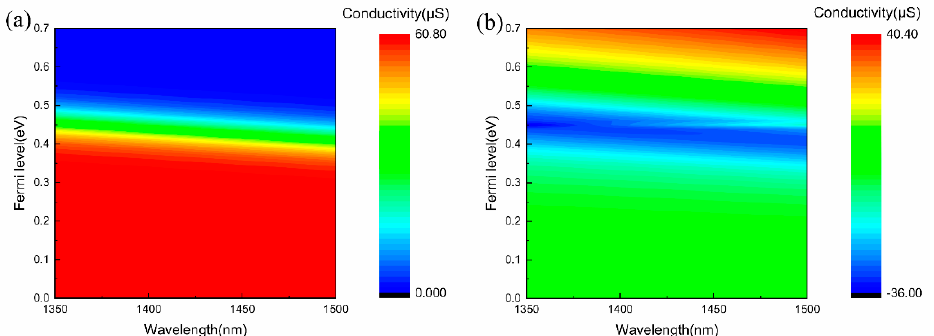
Figure 2. The relationship of graphene’s conductivity with different incident wavelengths and Fermi levels. ( a ) Real part of the conductivity. ( b ) Imaginary part of the conductivity.